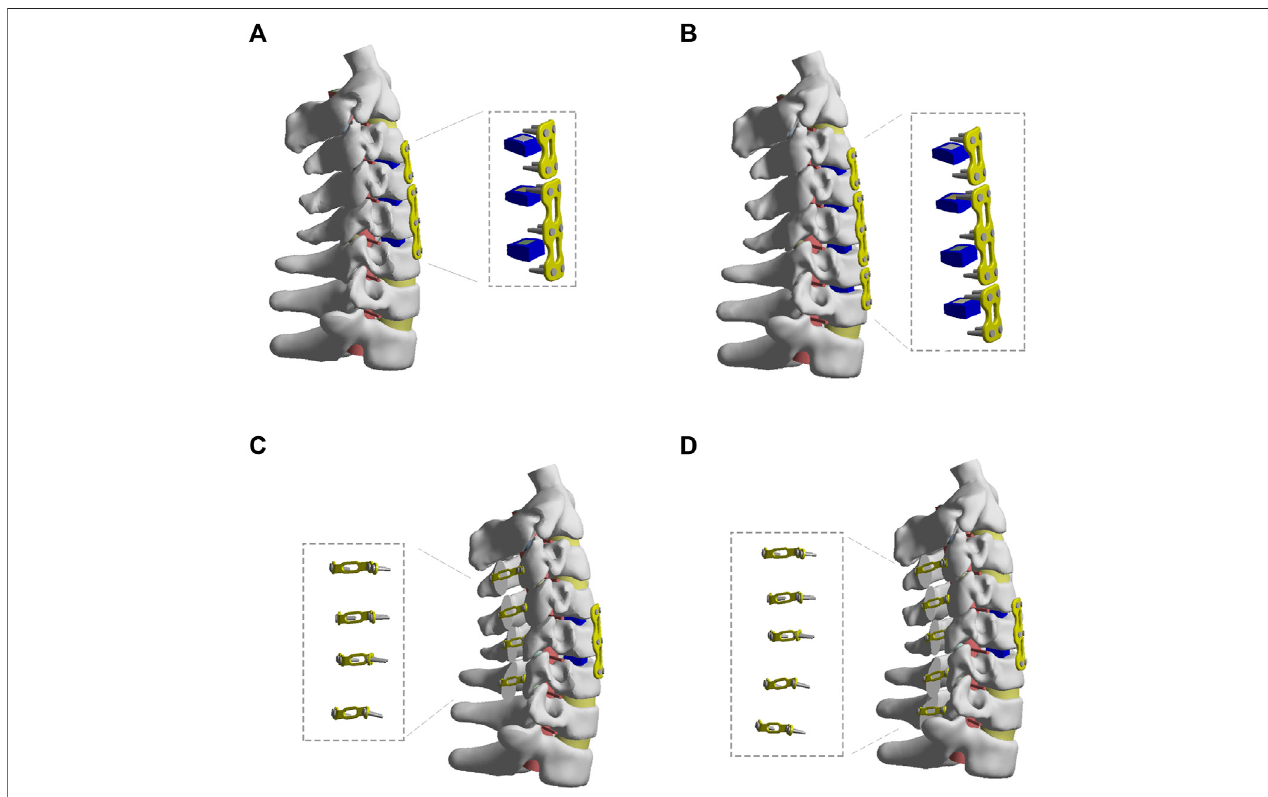
FIGURE3| TheFEmodelsofdifferentrevisionsurgeriesafterC4-C6ACDF. (A) TherevisionsurgeryofC2-C3ACDF. (B) TherevisionsurgeryofC3-C4andC6-C7 ACDF. (C) The revision surgery of C3-C6 laminoplasty. (D) The revision surgery of C3-C7 laminoplasty.